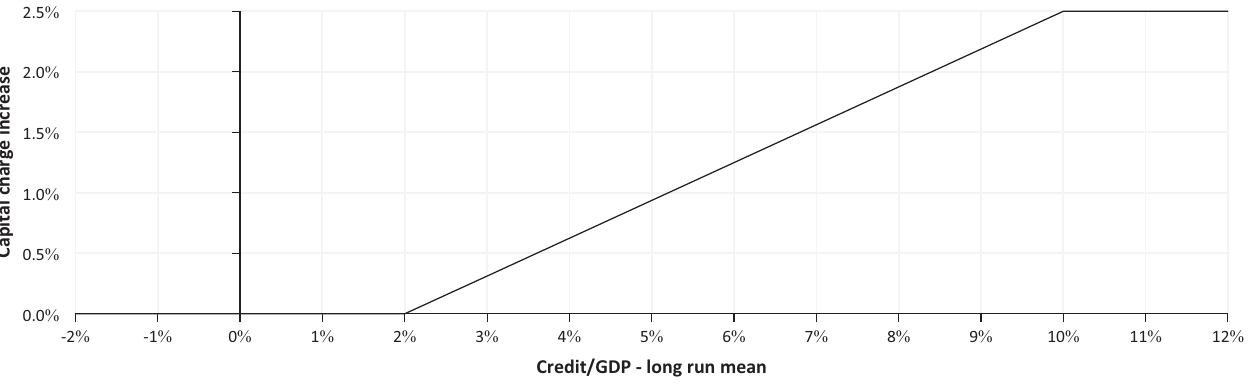
FIGURE 3: The Basel III procyclical capital rules for various credit growth/GDP gap levels.